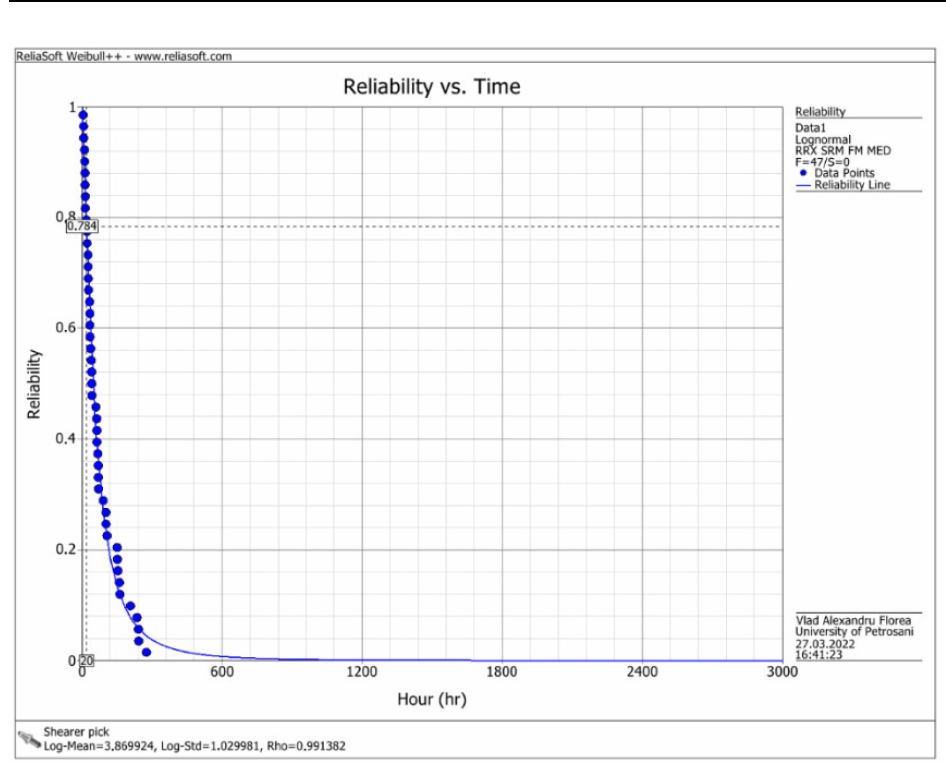
Figure 9. Cleat reliability values for a 78.4% confidence level for the shearer